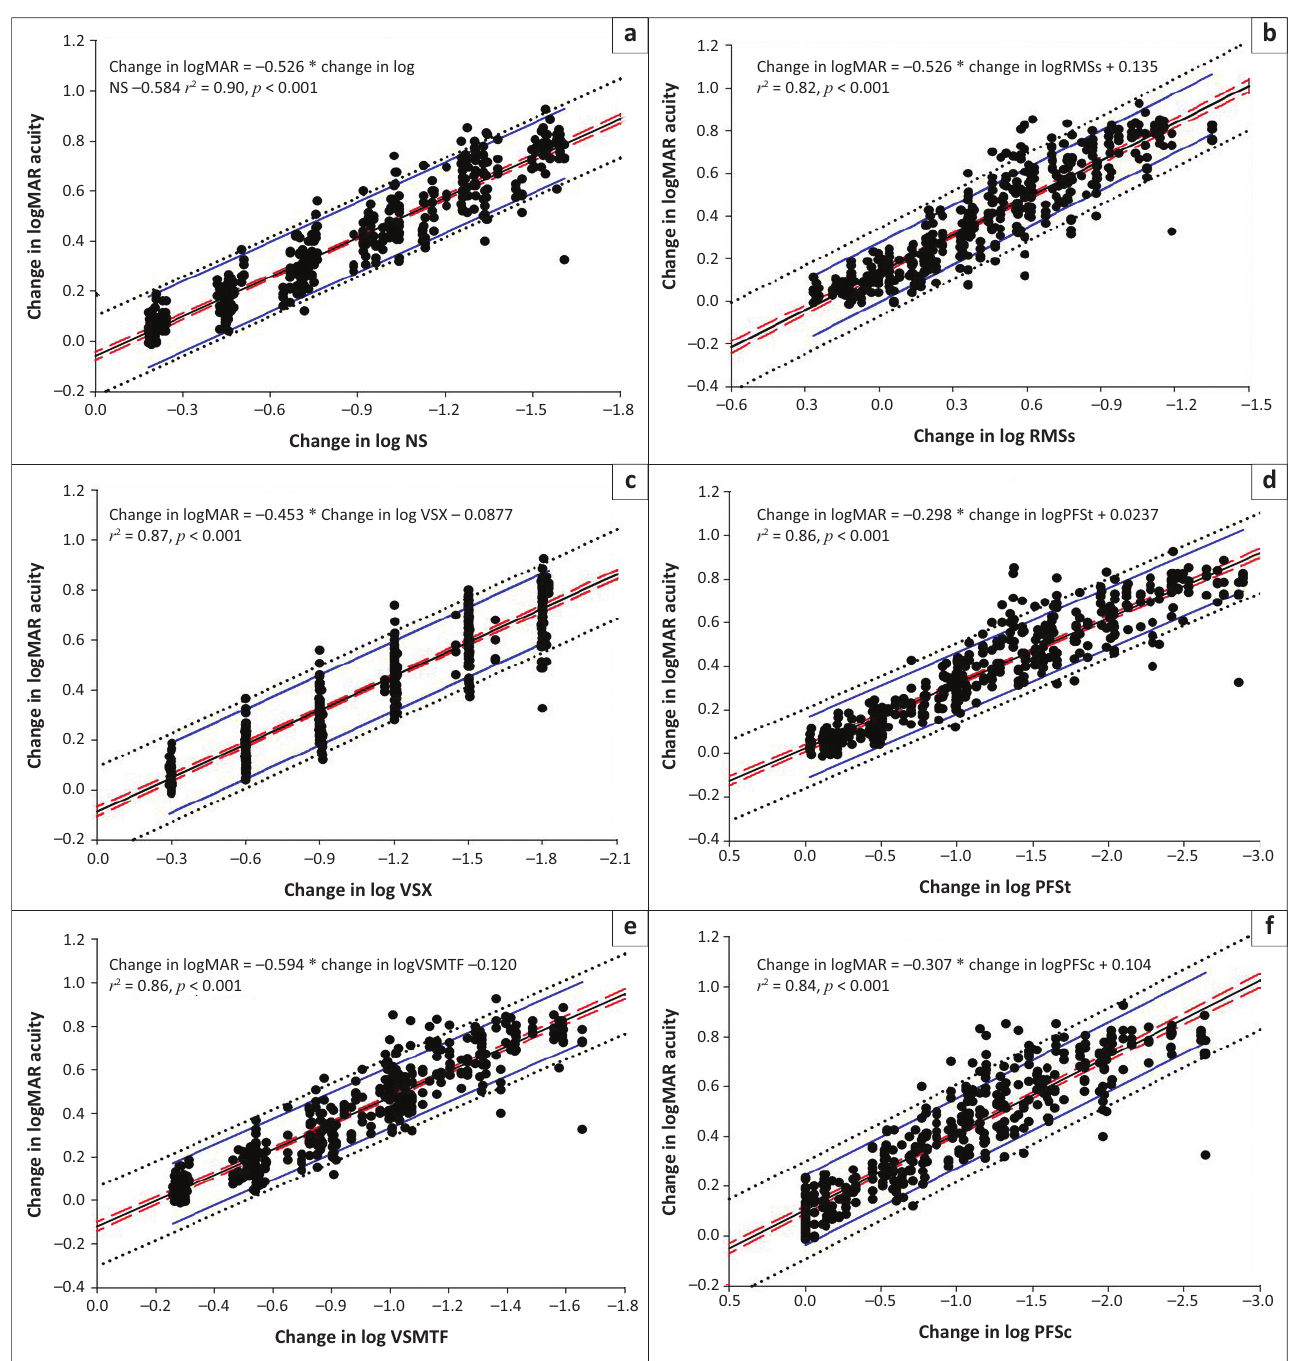
FIGURE 1: The scatterplots demonstrate the change in visual acuity as a function of change in six quality metrics. The central black line represents the best-fitting regression line, and the black dotted line represents the 95 % confidence interval defined by the data. The red dashed lines represent the 95 % confidence interval for the regression, while blue lines represent the 95 % confidence interval from the regression line for clinically significant change in acuity as defined by Arditi and Cagenello (1993).